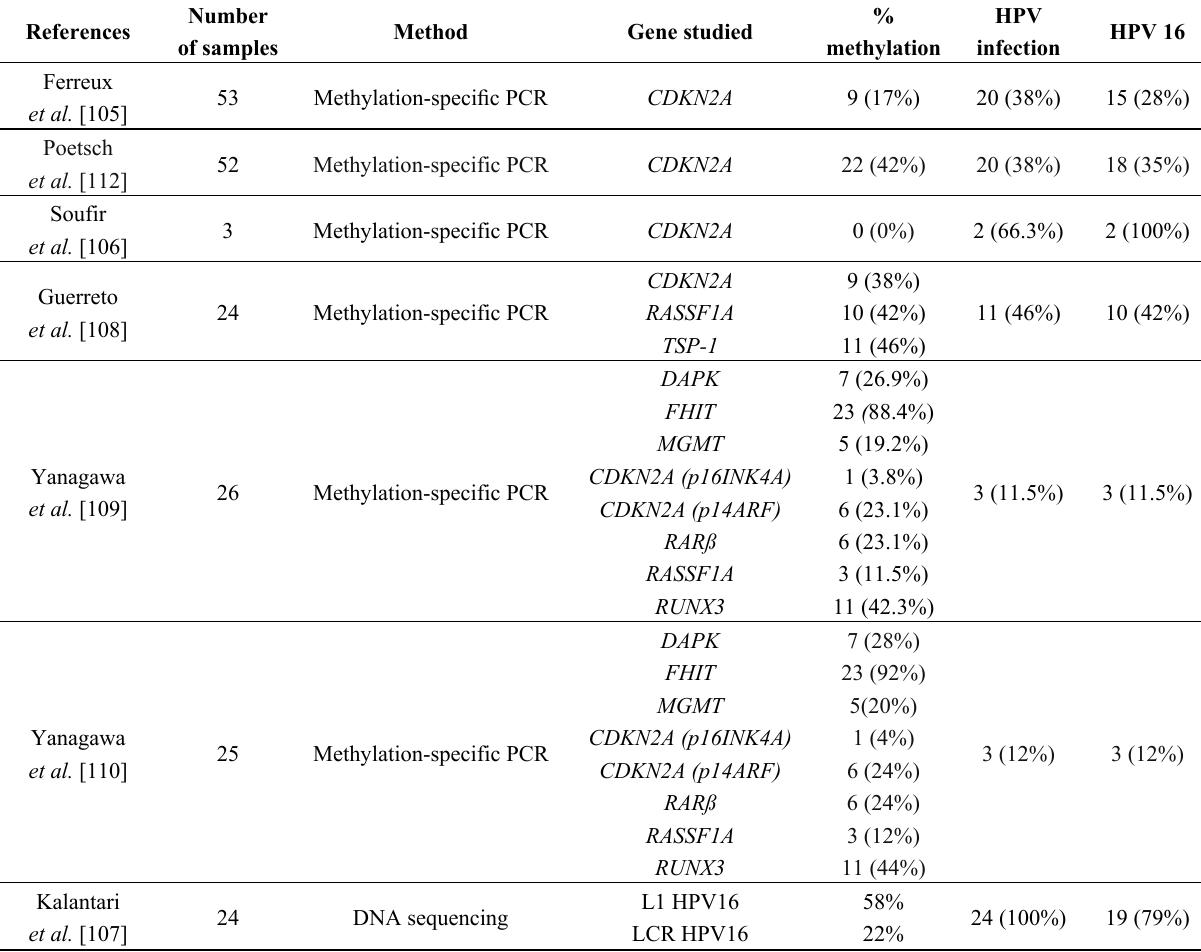
Table 1. Summary of the epigenetics studies in penile carcinomas described in the